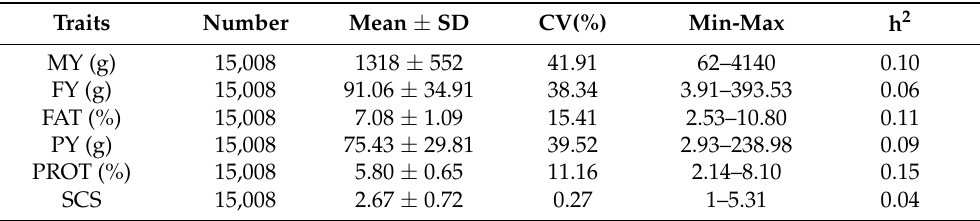
Table 1. Descriptive statistics for studied